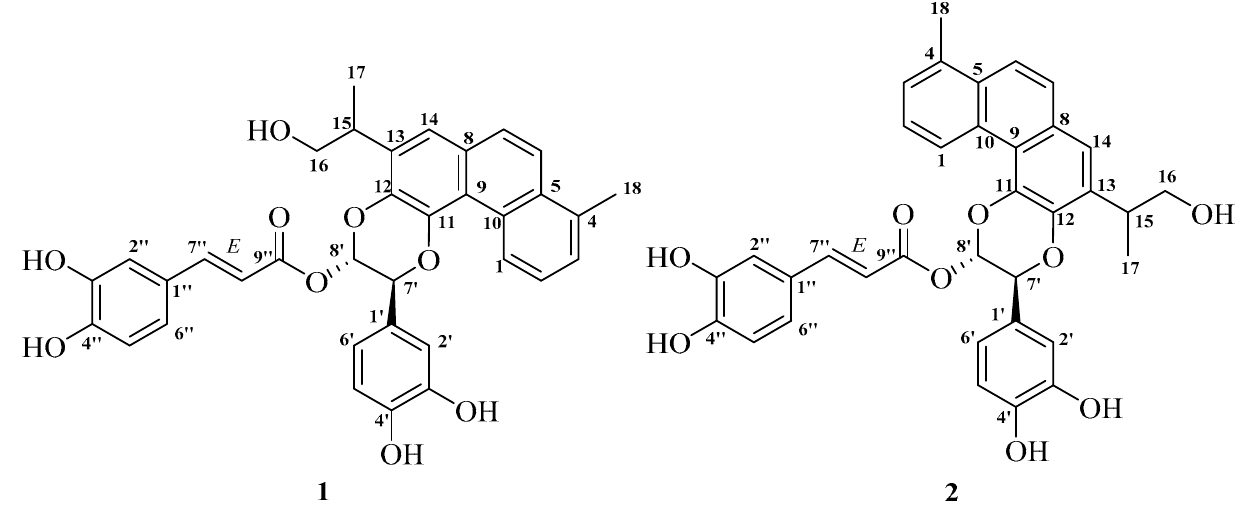
Figure 1. Structures of new compounds 1 and 2.